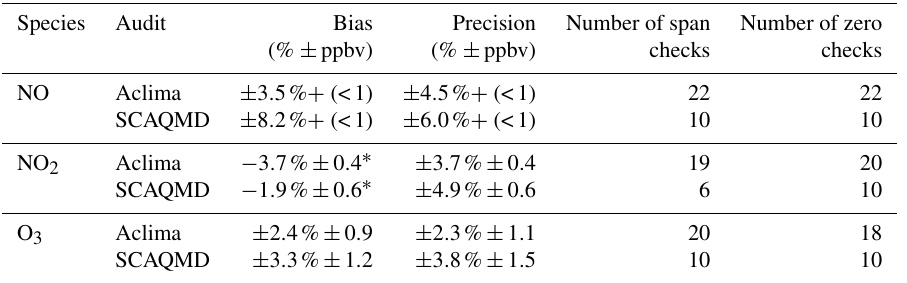
Table 8. External calibration checks (zero and span) performed in Los Angeles with equipment and gas standards managed by the SCAQMD compared with internal checks performed by Aclima 1 month prior to the Los Angeles deployment, 1 month following this deployment, and during a 1-week return to San Francisco in the middle of the deployment. External and Aclima calibration checks were conducted through the inlet lines of the mobile